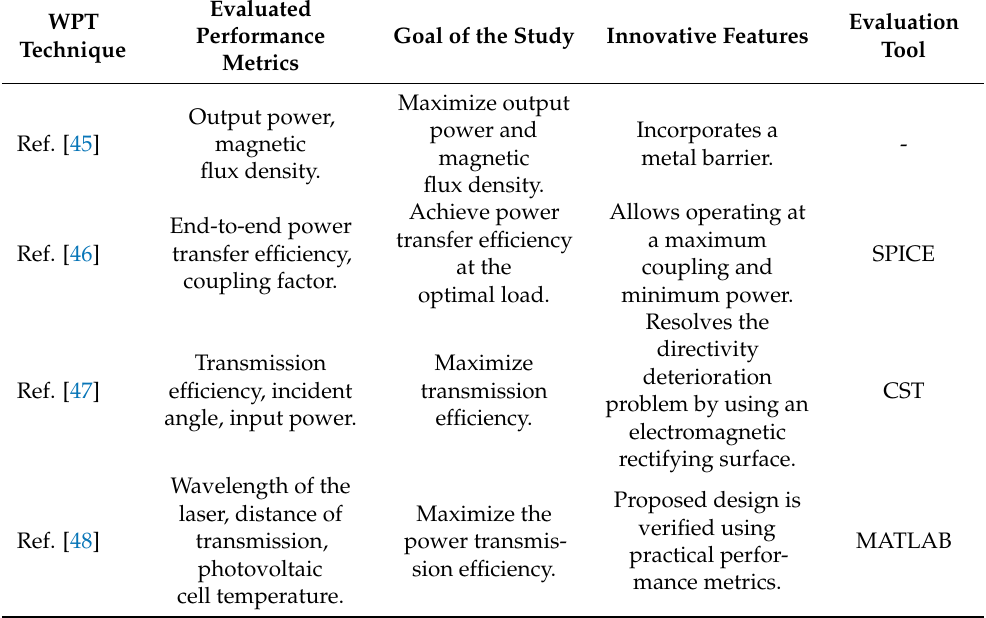
Table 6. Comparison of existing WPT techniques in terms of the evaluated performance metrics, objective, and outstanding